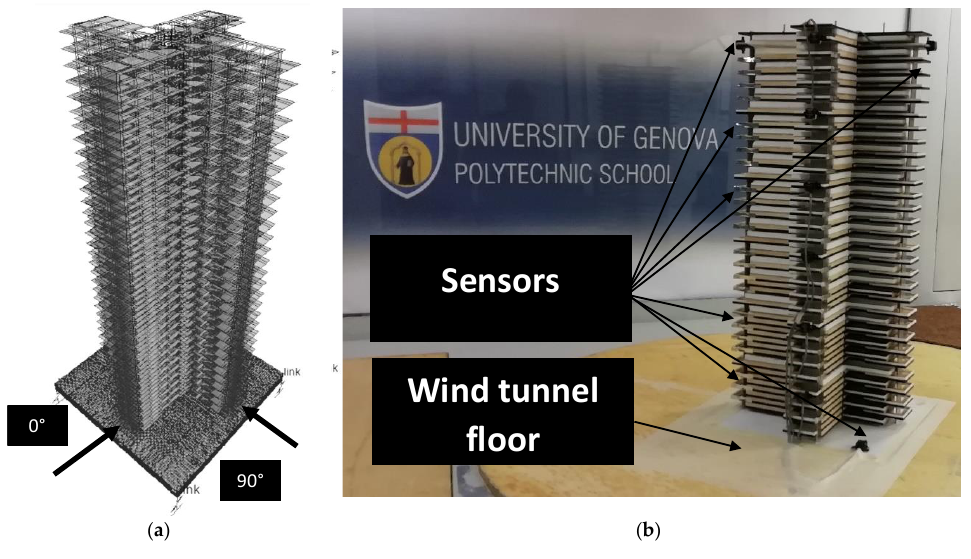
Figure 1. Structural ( a ) and experimental ( b ) setup.